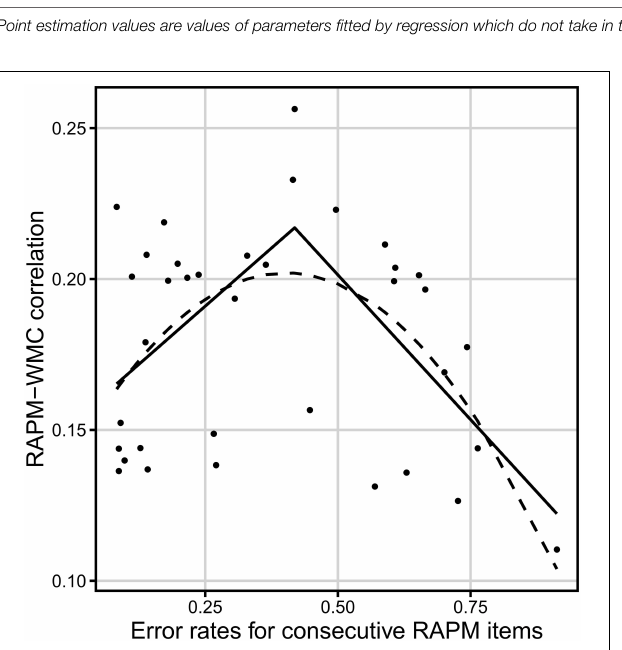
FIGURE 7 | Relation between the dificulty of a Raven-test item (error FIGURE 8 | Comparison of three measures as a function of the rate) and the correlation between accuracy on that item and WMC consecutive bins increasing in difficulty. Left: the observed (solid line) and (measured by the short-term memory and relational integration task). predicted (dotted line) bin correlation with WMC (measured by the short-term The solid line represents the segmented regression line. The dashed line memory and relational integration task). Right: the proportion of floor/ceiling reflects the quadratic regression line N 939 . effect (dashed line) N 939 = =